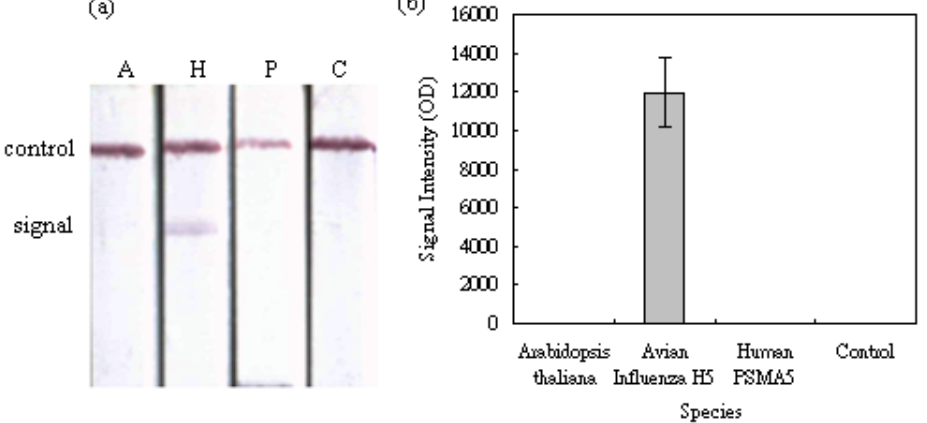
Figure 4. The selectivity test of the MBLF Strips. ( a ) MBLF test on the genetic sequences of (A) Arabidopsis thaliana , (H) H5 AIV, and (P) human PSMA5 PCR products, respectively, from left to right. Each analyte was loaded with 200 ng. The control strip (C) on the farther right was loaded with the running buffer only. A 12 V electric field was applied and the strip width was 5 mm. ( b ) Quantitative analysis of the signal readings.